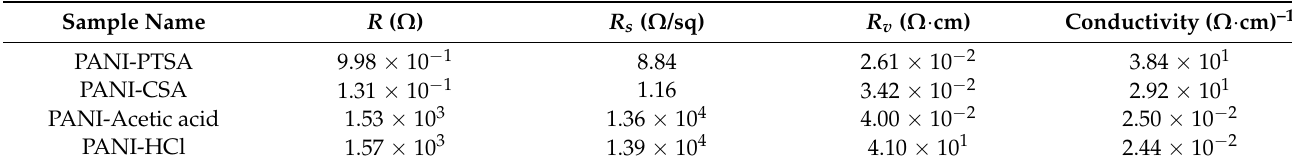
Table 7. Electrical data of PANI